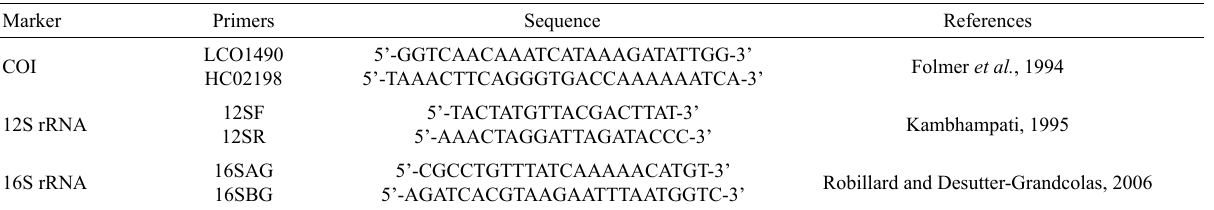
Table 2 – Primers used for PCR amplification and sequencing, indicating the gene, described name, sequence, and source of each sequence primer. Marker